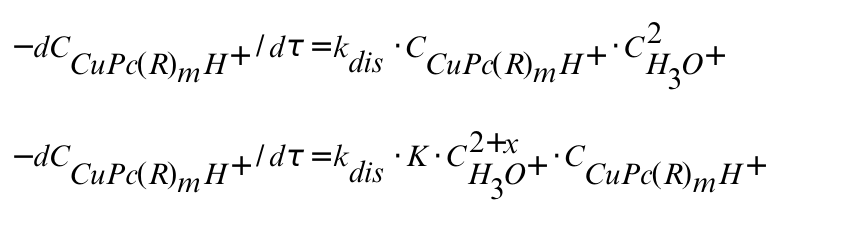
, the activation energies and entropies of dissociation of nitro derivatives Table 4. The rate constants k dis of copper(II)phthalocyanines in sulphuric